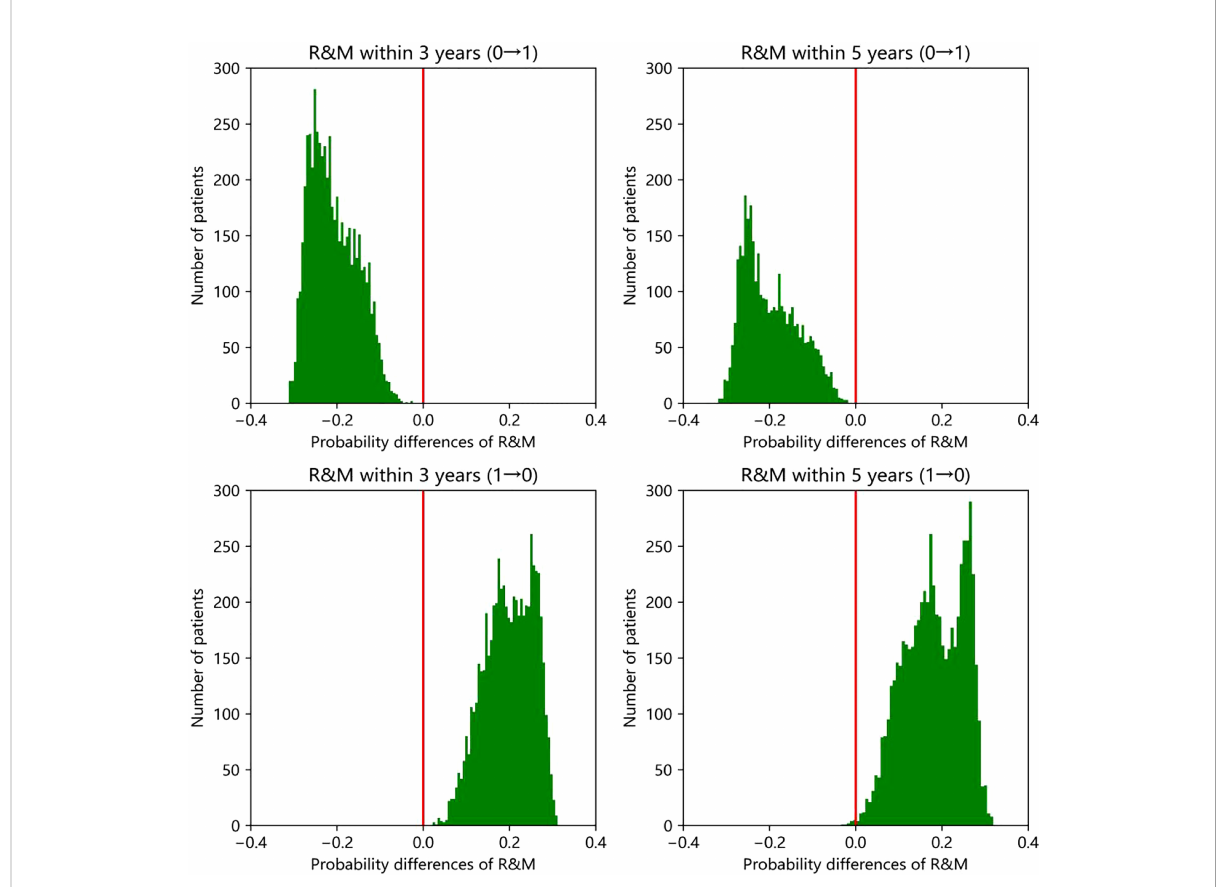
FIGURE 6 Effect of Chinese medicine on probability of R&M in XGBoost